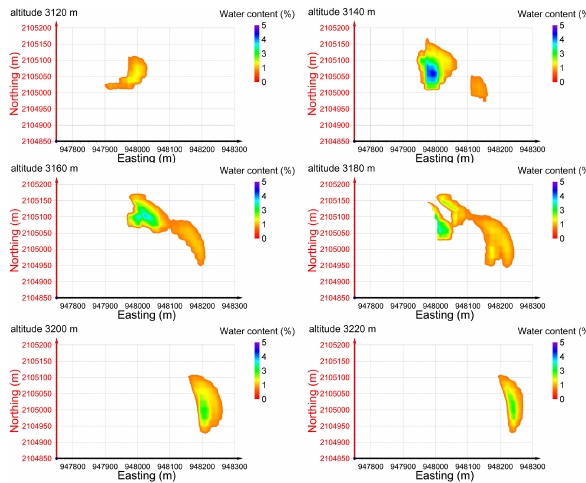
Fig. 14. 3-D-SNMR image of the water-filled cavern observed in October 2012 and shown as slices at different